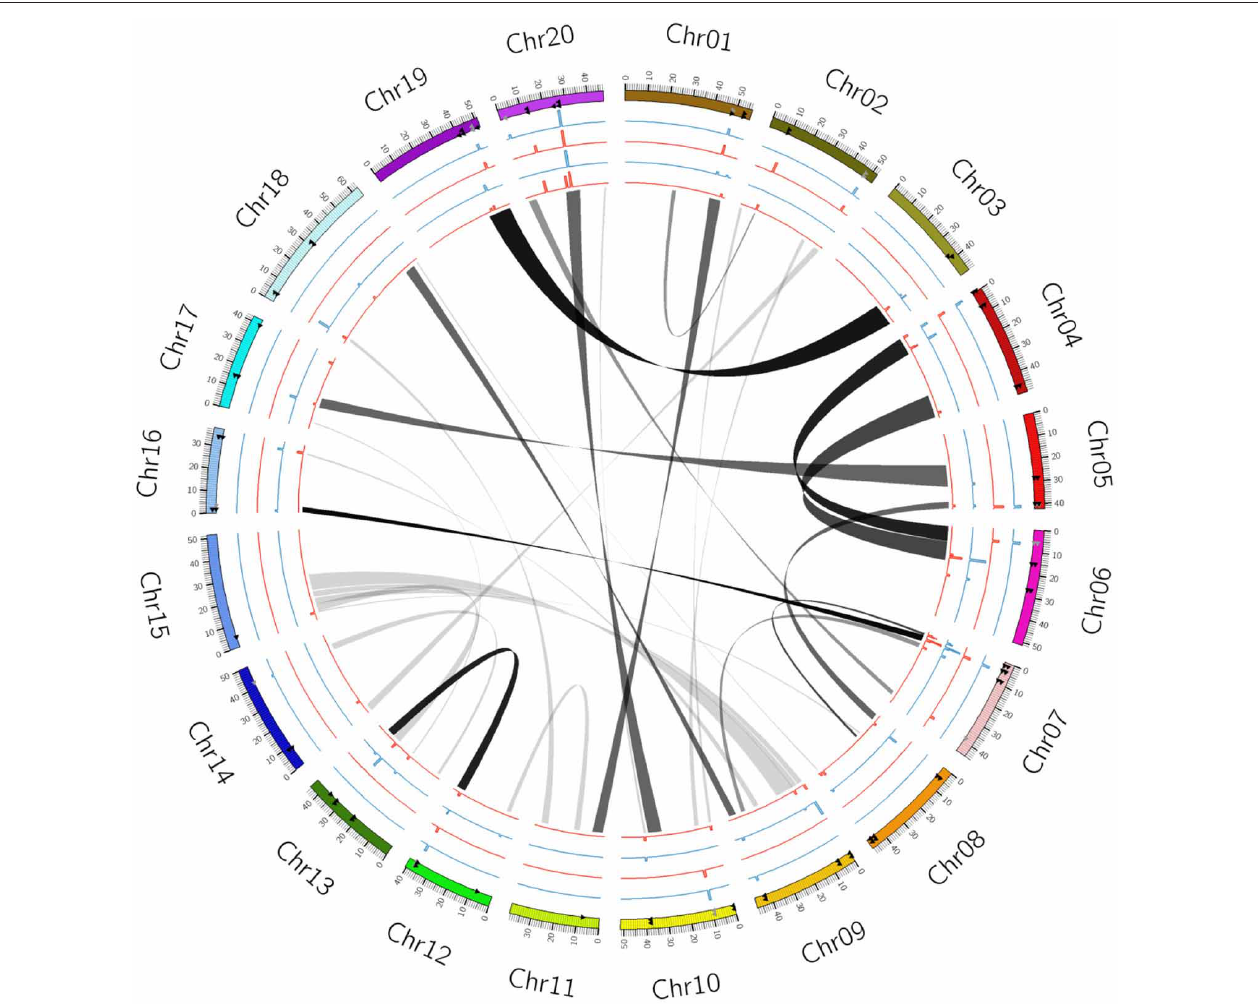
locations. Gray ribbons represent as duplicated positions of the G. max genome after similar duplicated regions are grouped as bundles. Circular lines from the inner to the outer: 1, LOD of protein QTL (red); 2, R 2 of protein QTL (blue); 3, LOD of oil QTL (red); 4, R 2 of oil QTL